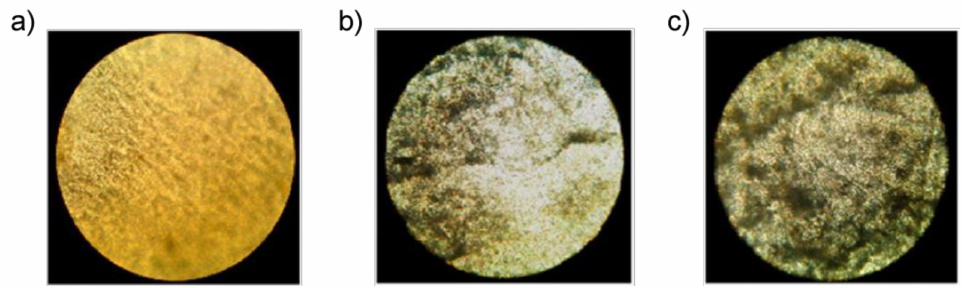
Figure 7. Micrographs of composite PE/NR = 70/30: ( a ) original sample, ( b ) sample after aging in soil for 45 days, ( c ) sample after aging in soil for 90 days. All micrographs were taken in transmitted light at a magnification of 100 × . Adapted from Mastalygina Elena et al.